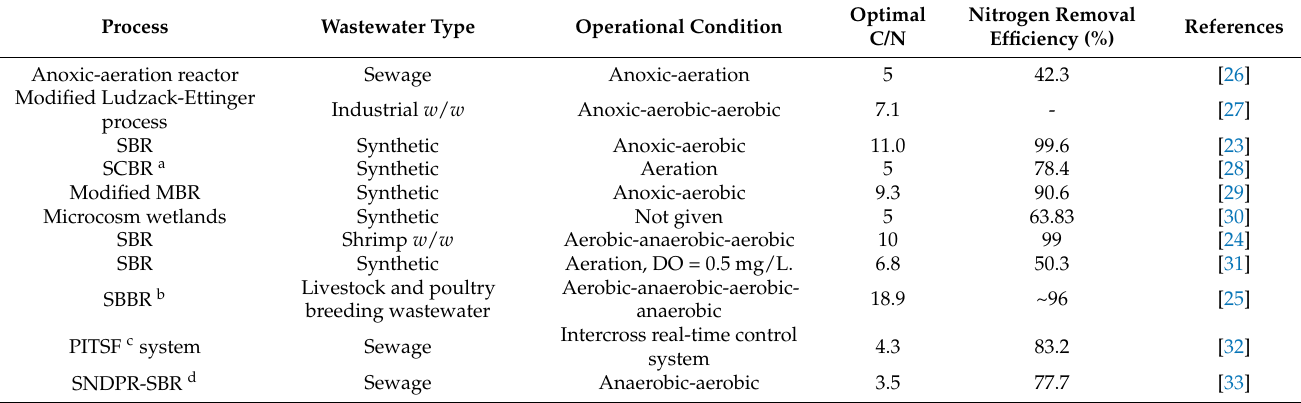
Table 1. Optimal carbon to nitrogen (C/N) ratio of different processes and operational conditions.